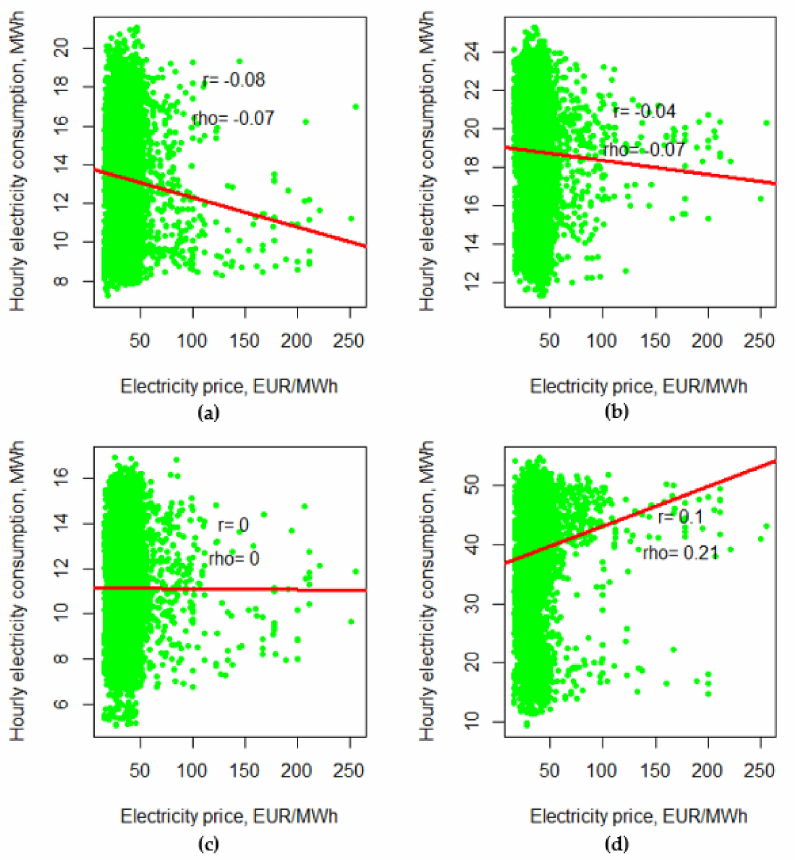
Figure 16. Correlation between the hourly electricity prices and electricity consumption for the analyzed case of the research objects: ( a ) M1, ( b ) M2, ( c ) M3 and ( d ) M4. Source: own study in the RStudio